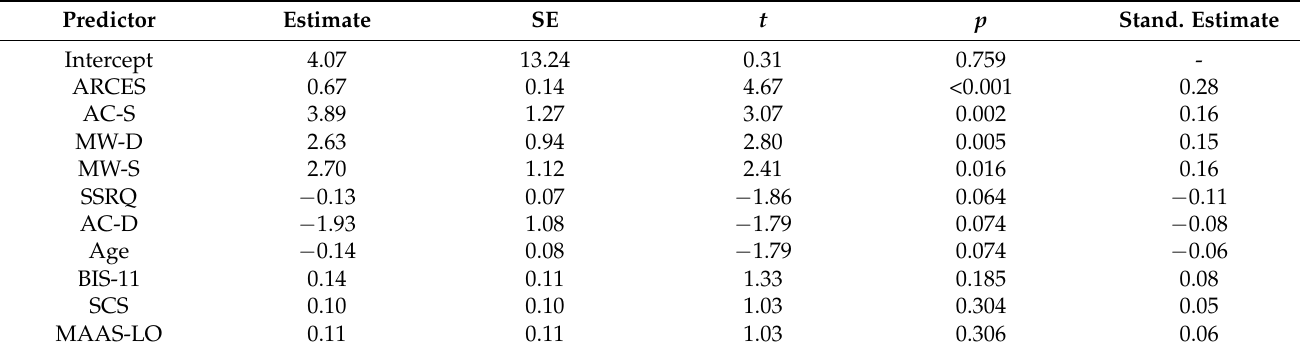
Table 4. Summary of expanded standard multiple regression analysis for attentional, psychosocial, personality, and demographic predictors of phubbing behavior ( N =